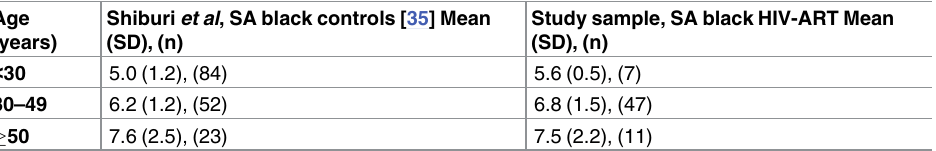
Table 3. Mean PWV (ms -1 ) in the South African (SA) black subpopulation: HIV-infected participants on ART compared to HIV-uninfected